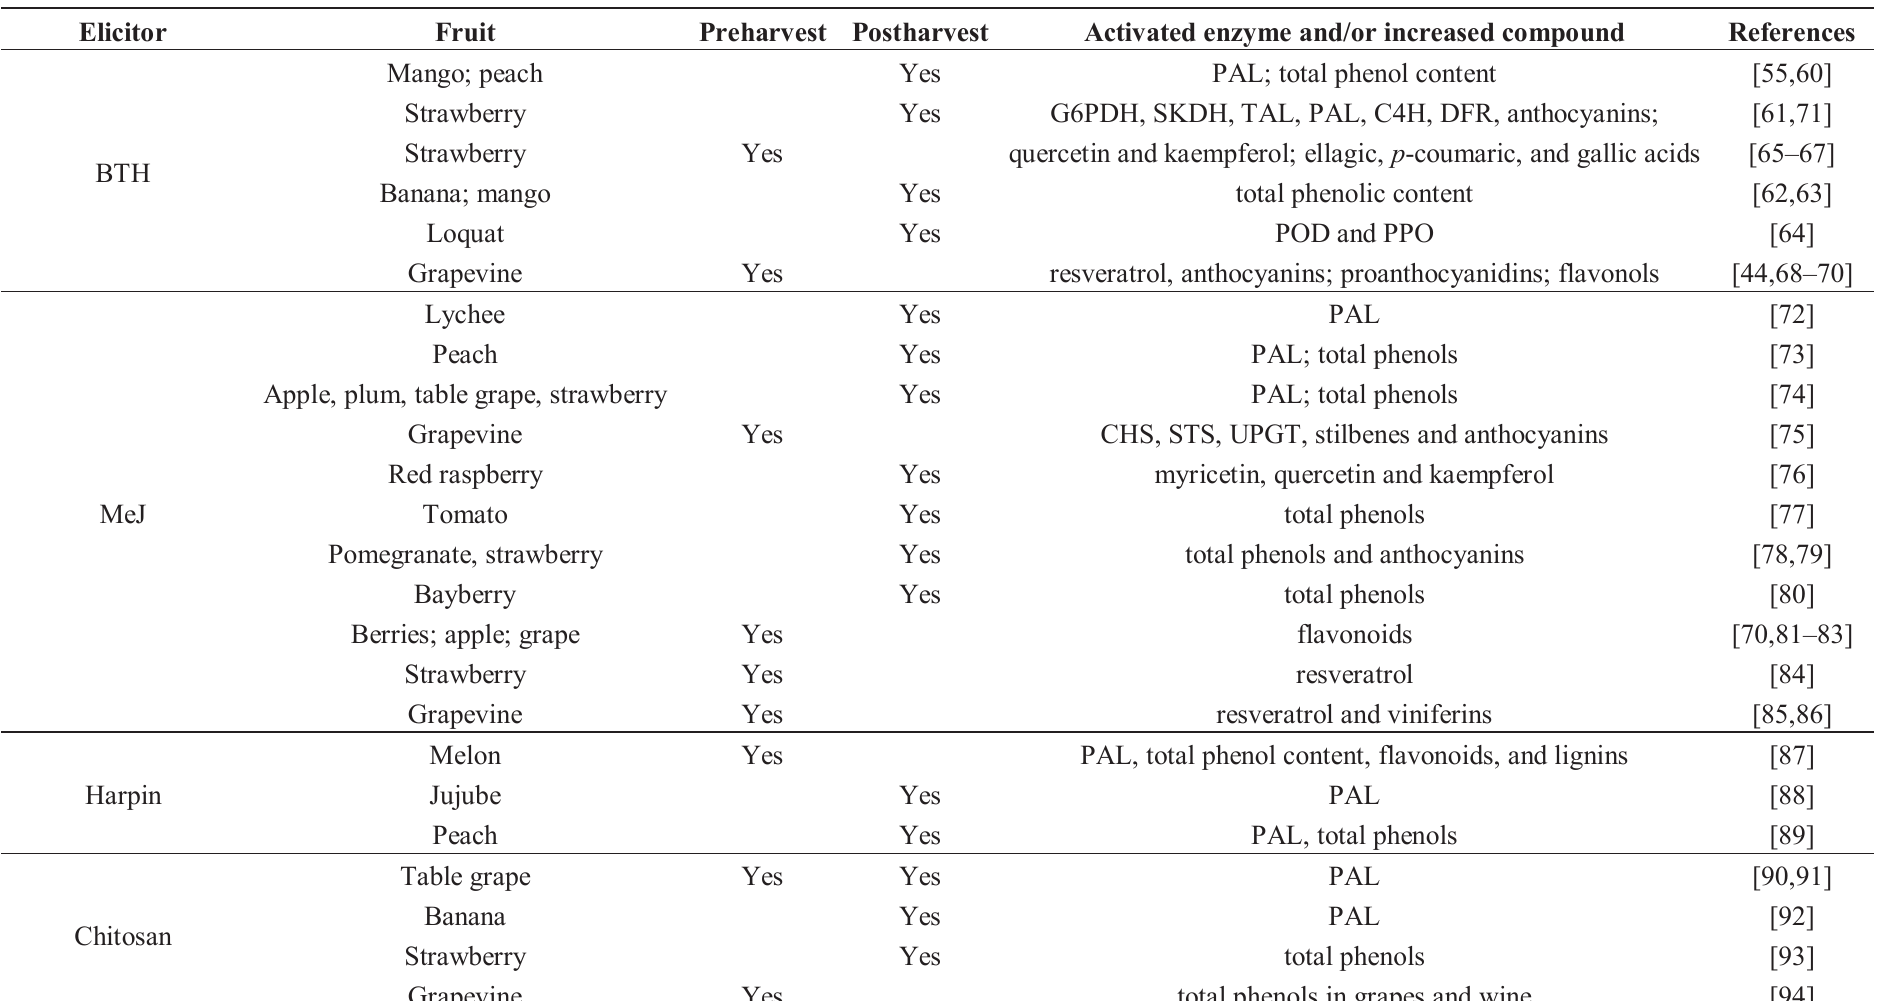
Table 1 . Summary of the effects of the application of different elicitors on polyphenol content and activity of polyphenol-related enzymes.